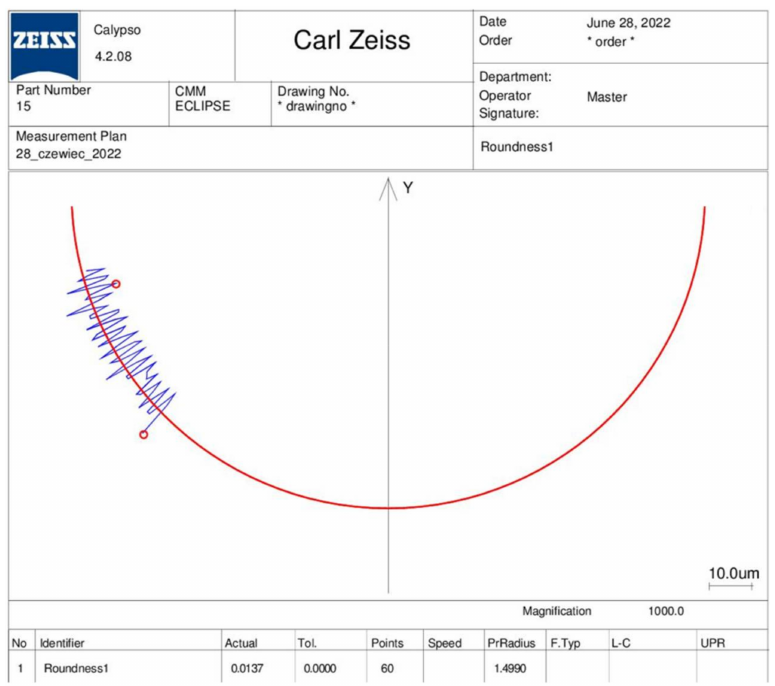
Figure 9. Measurement results of the deviation in the axial profile on CMM Zeiss Eclipse.